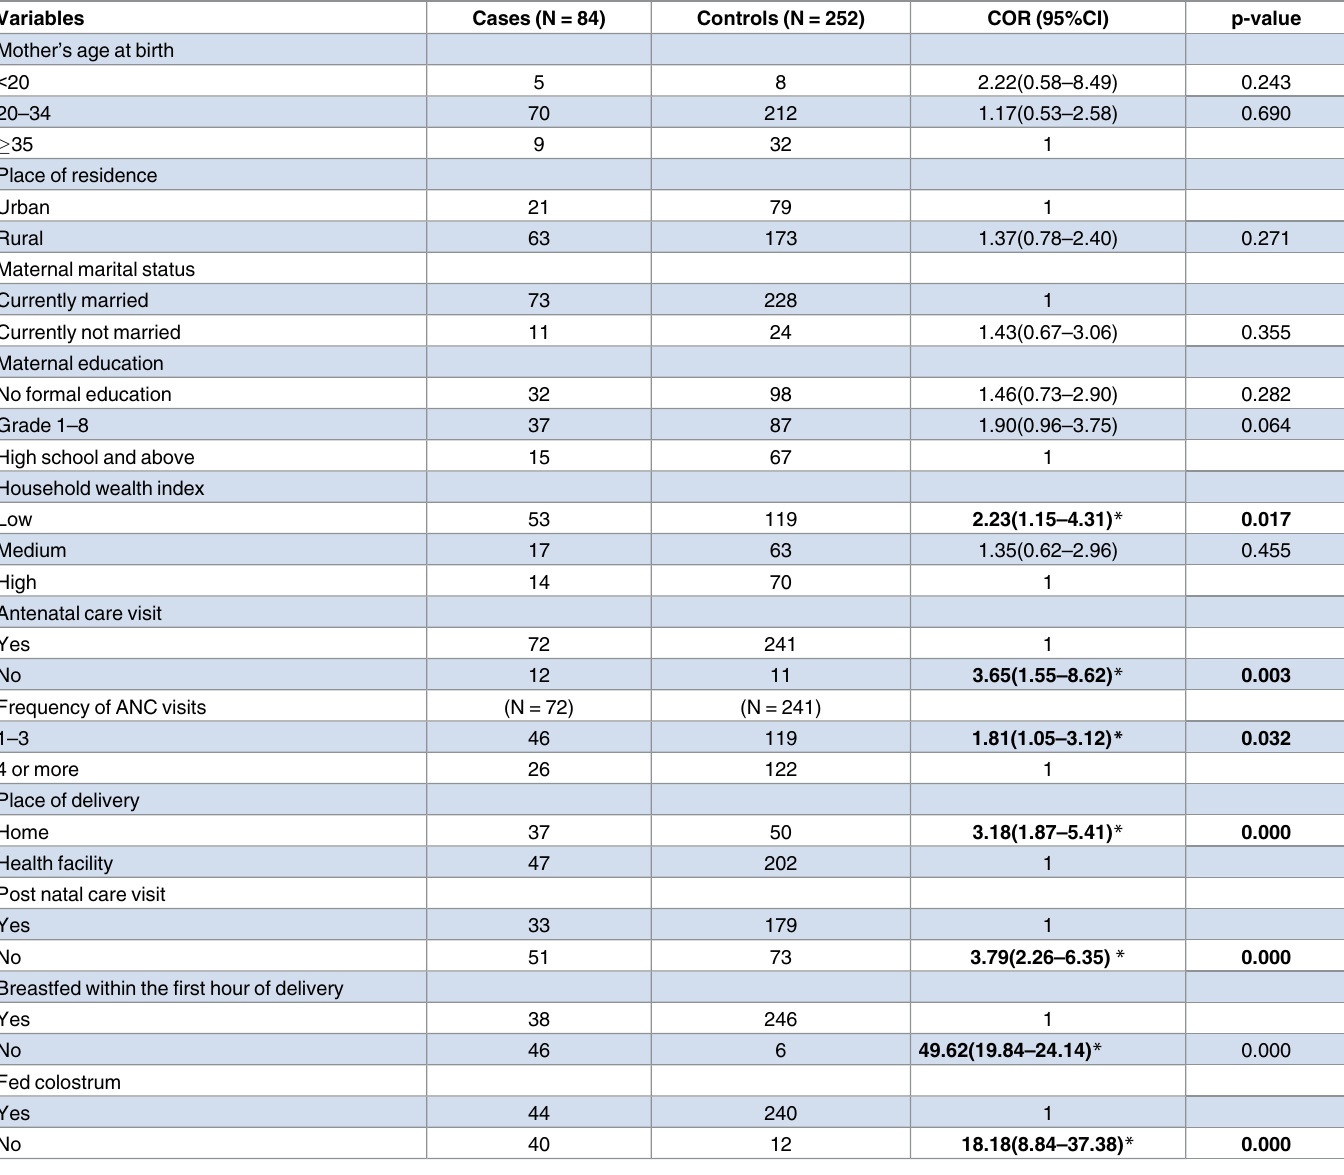
Table 1. Bivariate logistic regression analysis depicting the association between independent variables and neonatal mortality in North Shoa Zone of Amhara Regional State,